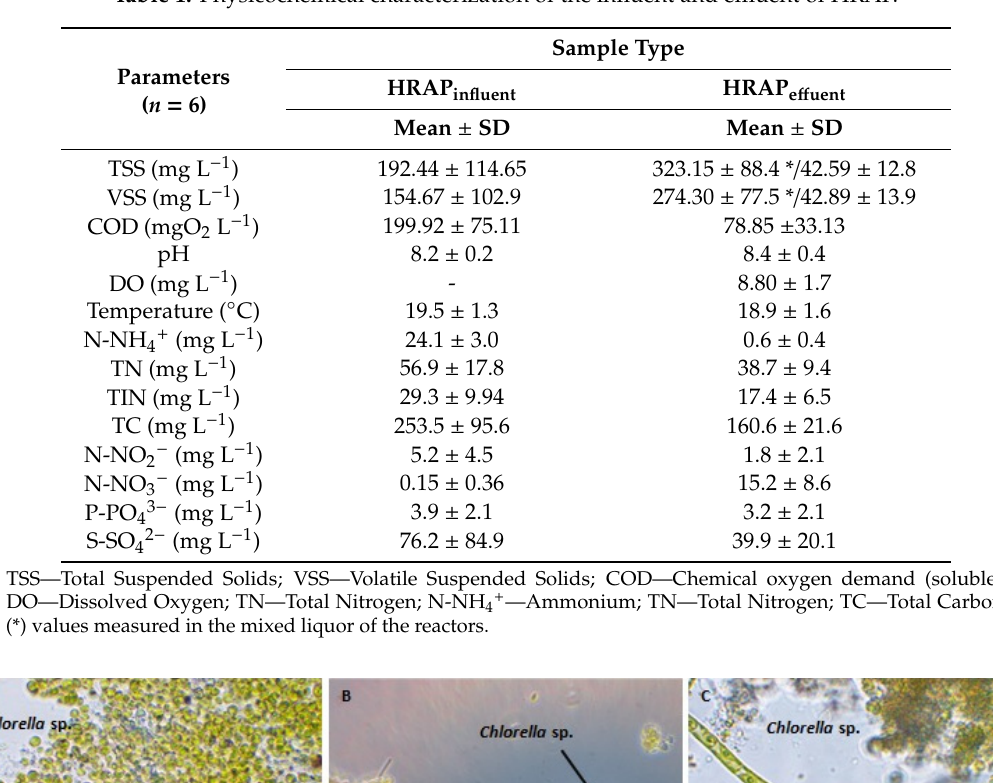
Table 1. Physicochemical characterization of the influent and e ffl uent of HRAP.